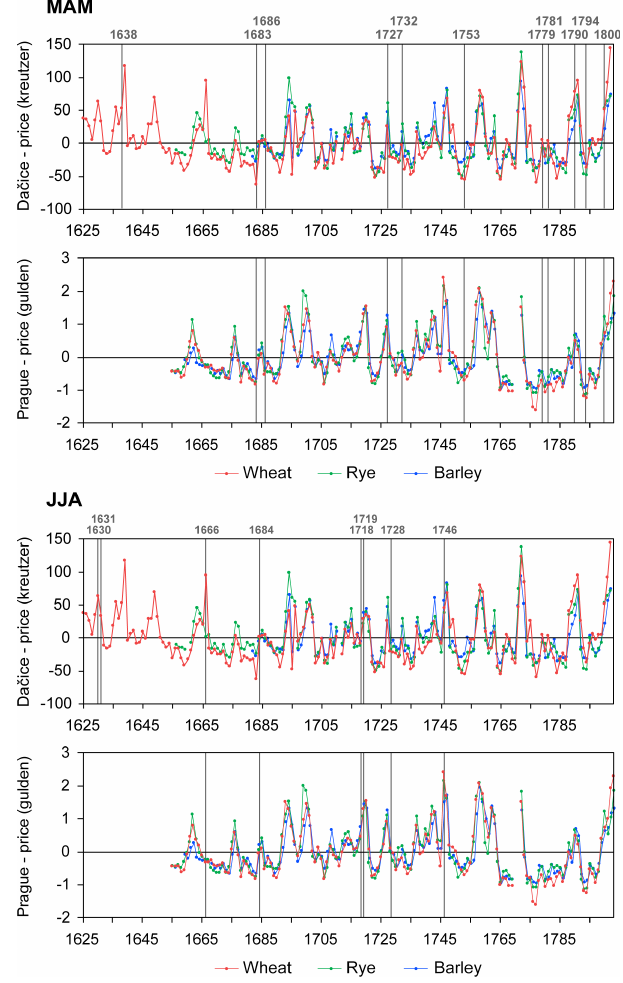
Figure 8. Deviations in grain prices (wheat, rye and barley) in Daˇcice for 1625–1803 (Brázdil and Durd’áková, 2000) and in Prague in 1655–1803 (Schebek, 1873) with an identification of ex- tremely dry MAM and JJA